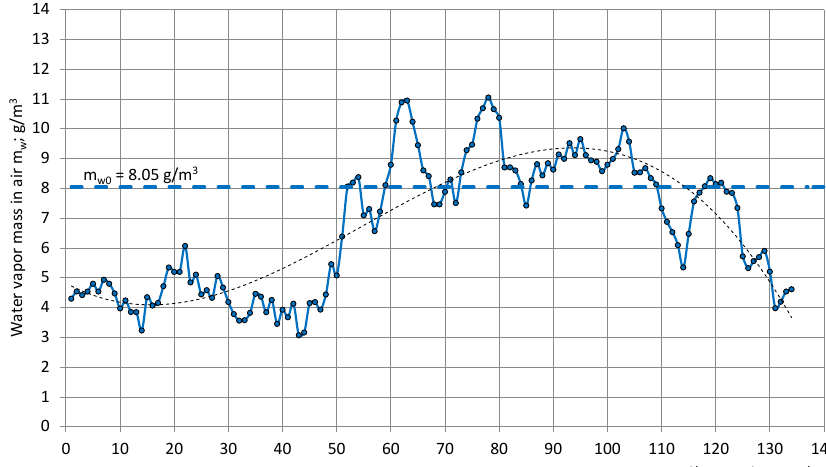
Figure 9. Water vapor mass m w in the air of the test room in the short series.